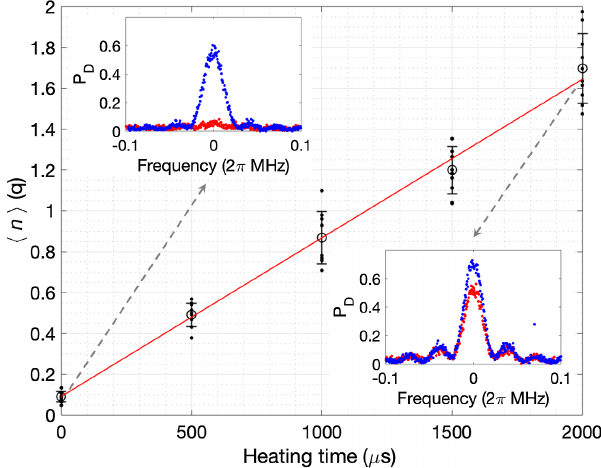
FIG. 2. h n i as a function of time using sideband amplitudes over the loading hole. Insets show the corresponding side- band amplitude measurements for h n i ¼ 0 . 1 (top) and h n i ¼ 3 (bottom). These measurements were taken using a free-space clock beam. The red and blue data correspond to the red and blue sidebands.